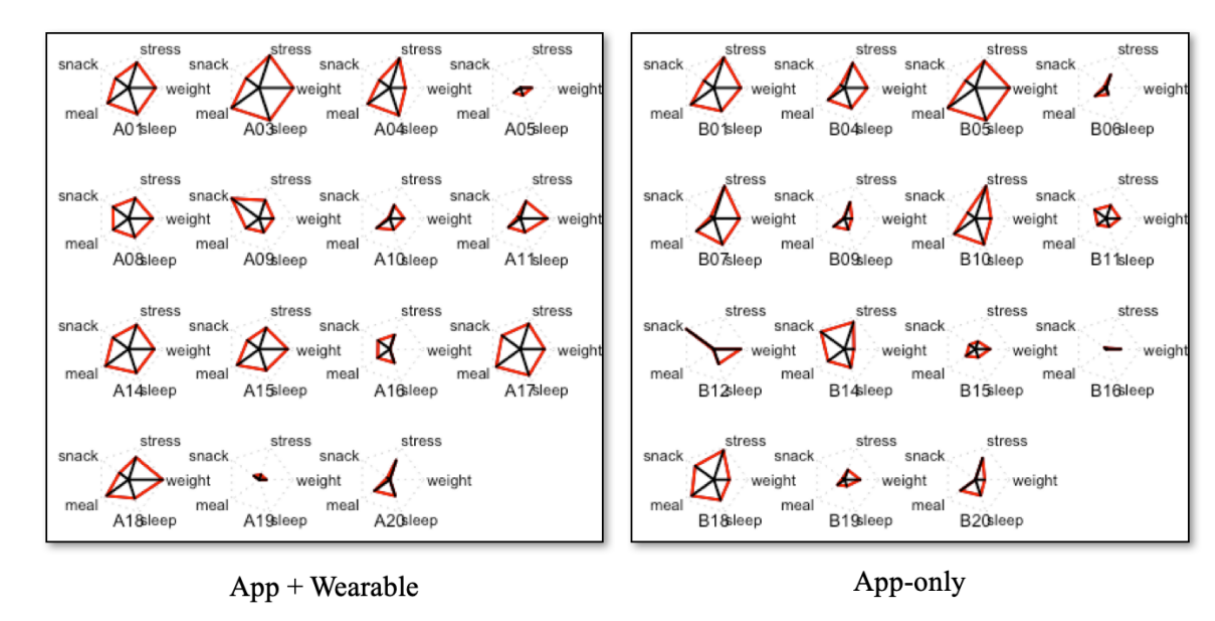
Figure 6. Star plot based on recorded lifelog per each